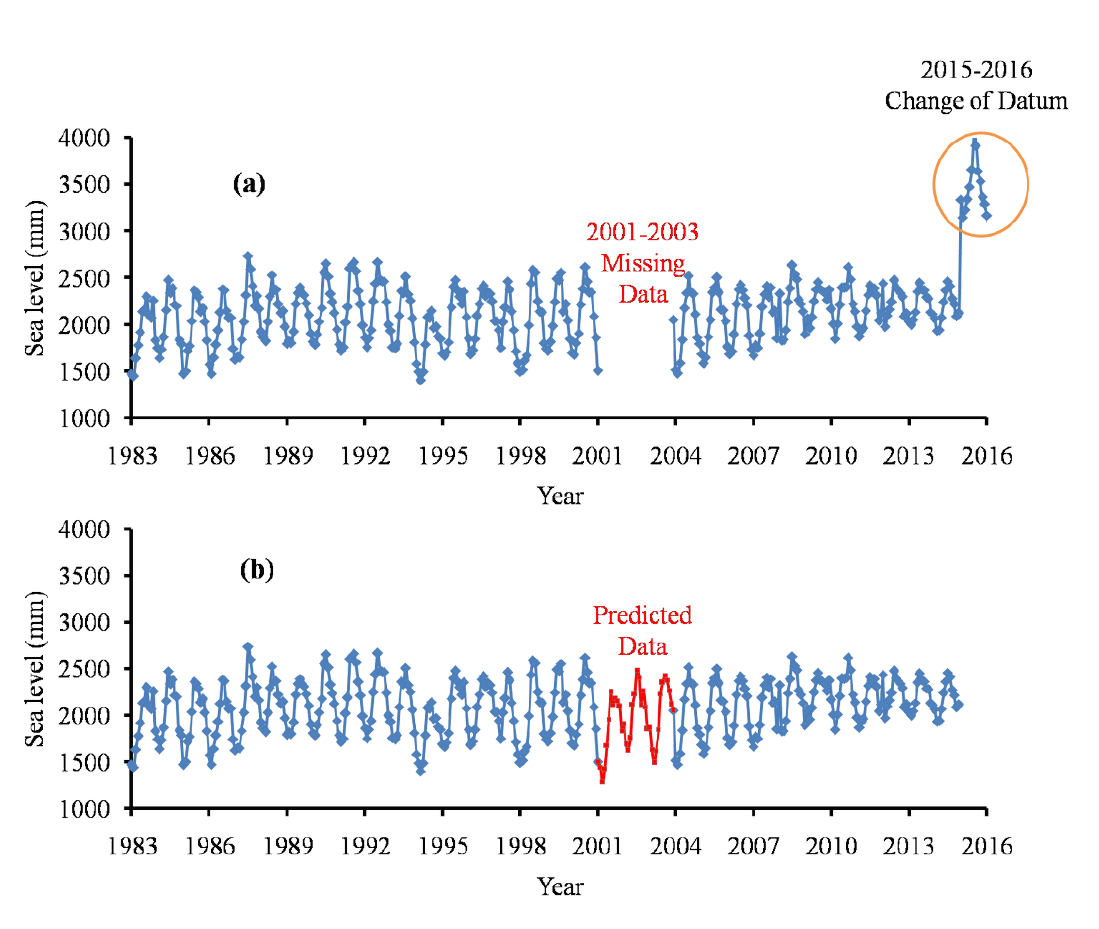
Figure 4. Sea-level trend: ( a ) time series of mean monthly sea level data at Cox’s Bazar station, ( b ) time series of mean monthly sea level data with predicted missing data (red series).